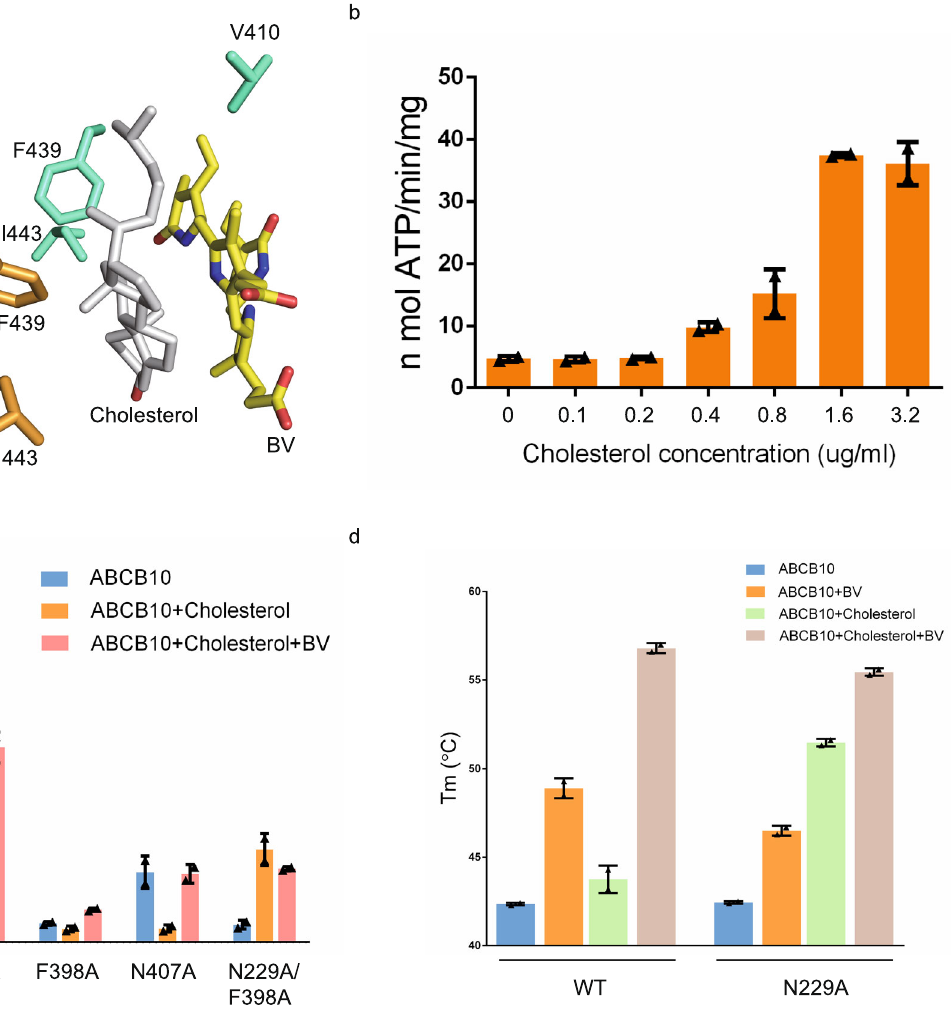
Fig. 5 | Cholesterol is a cofactor of ABCB10-BV. a Two cholesterol molecules are sandwiched by two biliverdin molecules. Zoom-in view of the interface between cholesterol (in gray) and BV. Residues that involved in cholesterol interaction are labeled. Biliverdins are shown in sticks and colored in yellow. b ATPase activity of ABCB10 with increasing concentration of cholesterol. ATPase activities are mea- sured at varied concentration of ABCB10 WT. Each data is presented as the means ±s.d. of three independent assays ( n =3). c ATPase activity of ABCB10 WT and